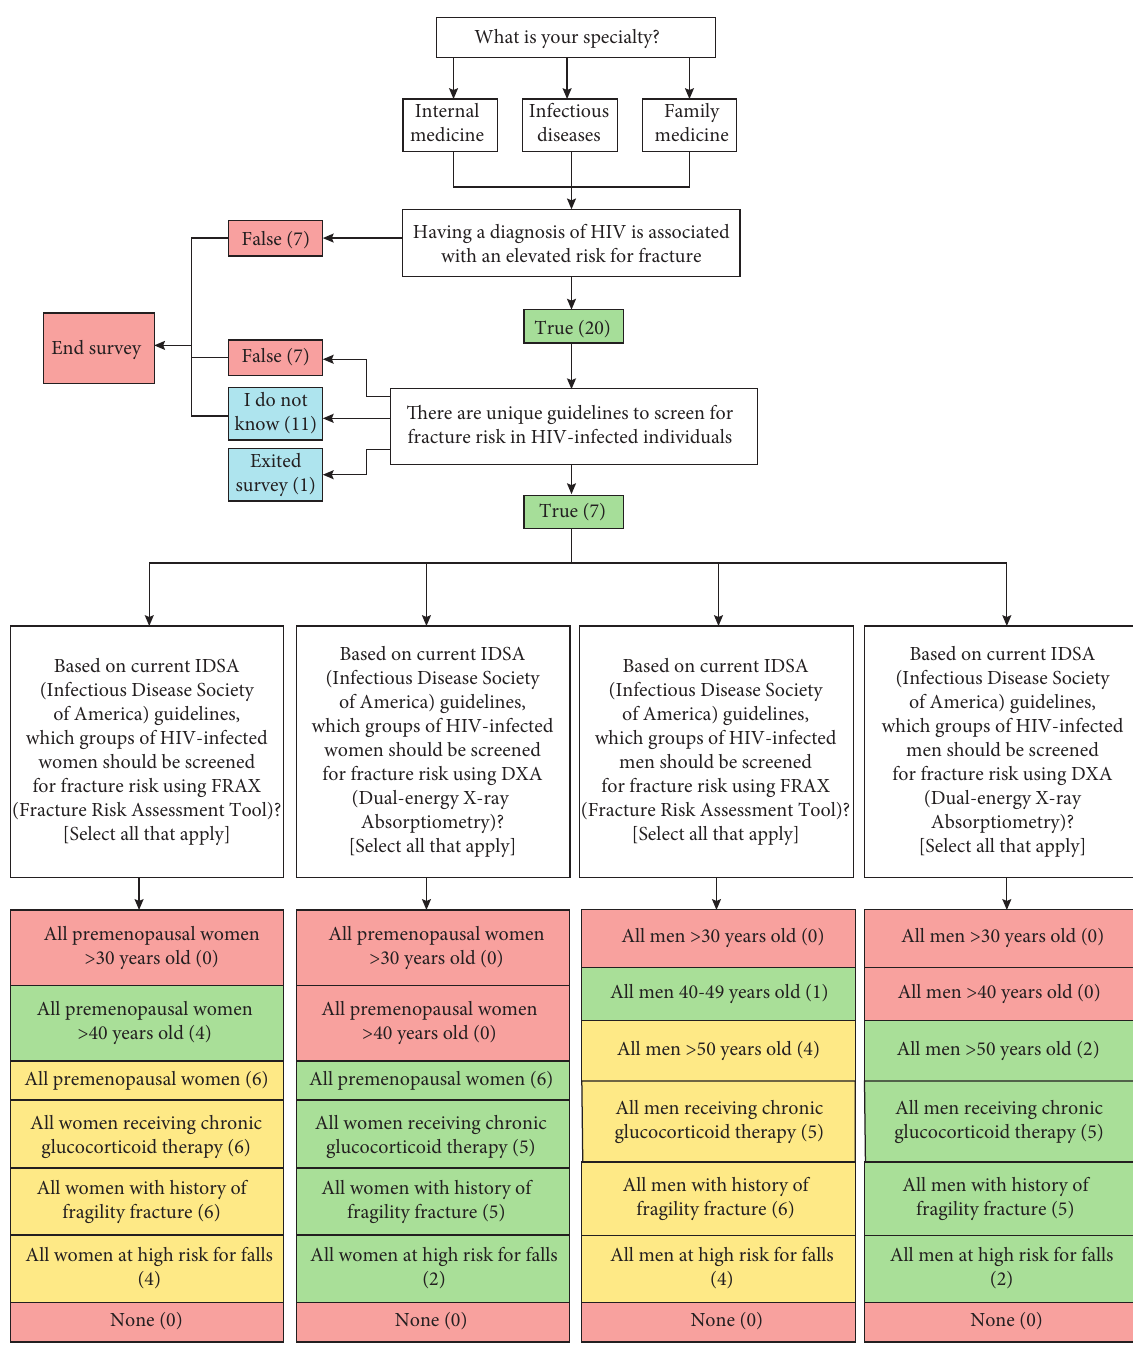
Note: green boxes represent answer choices that are consistent with guidelines; red boxes are inconsistent with guidelines. Yellow boxes represent the contingency in IDSA guidelines which state that “in resource‐limited settings, FRAX without bone mineral density can be substituted for DXA.” Figure 1: Electronic survey used to assess provider knowledge among PCP and ID specialists. The corresponding (n) refers to the number of providers that selected each